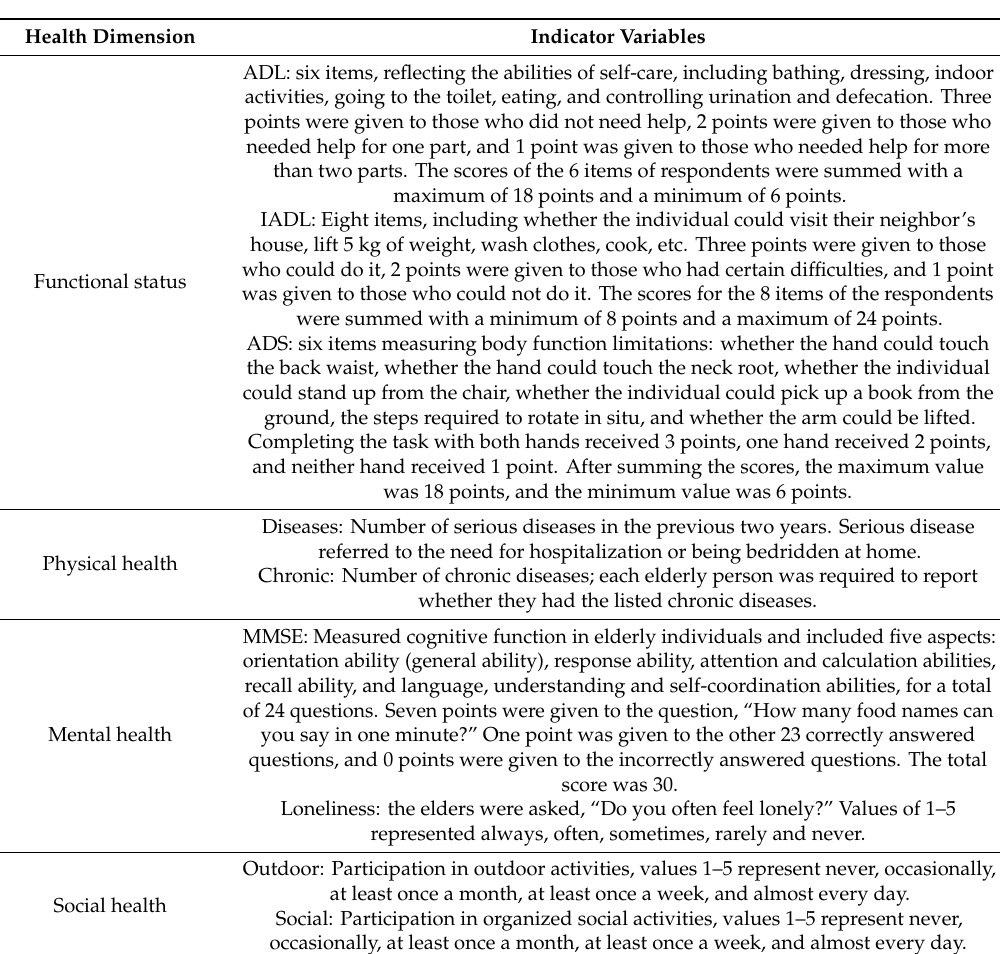
Table 1. Four Health Dimensions and Measurement